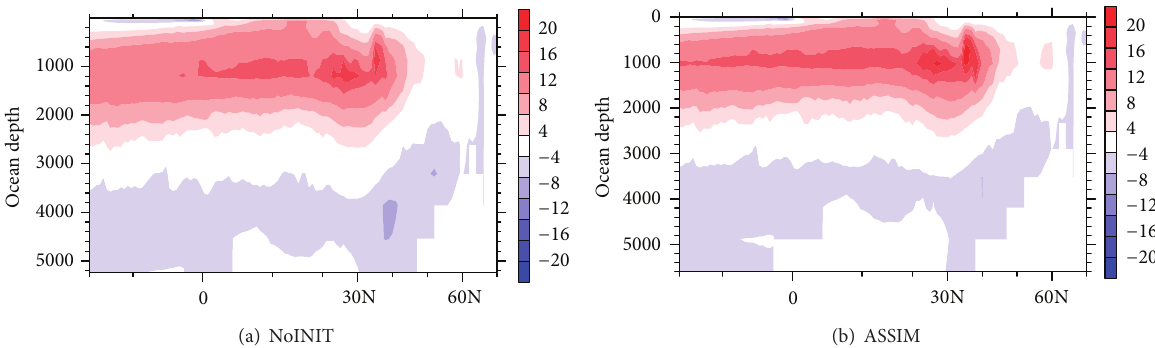
Figure 6: (a) Climatological Atlantic Meridional Overturning Circulation (AMOC) simulated by the ensemble mean of the NoINIT runs (units: Sv). (b) As in (a) but simulated by the ensemble mean of the ASSIM runs.